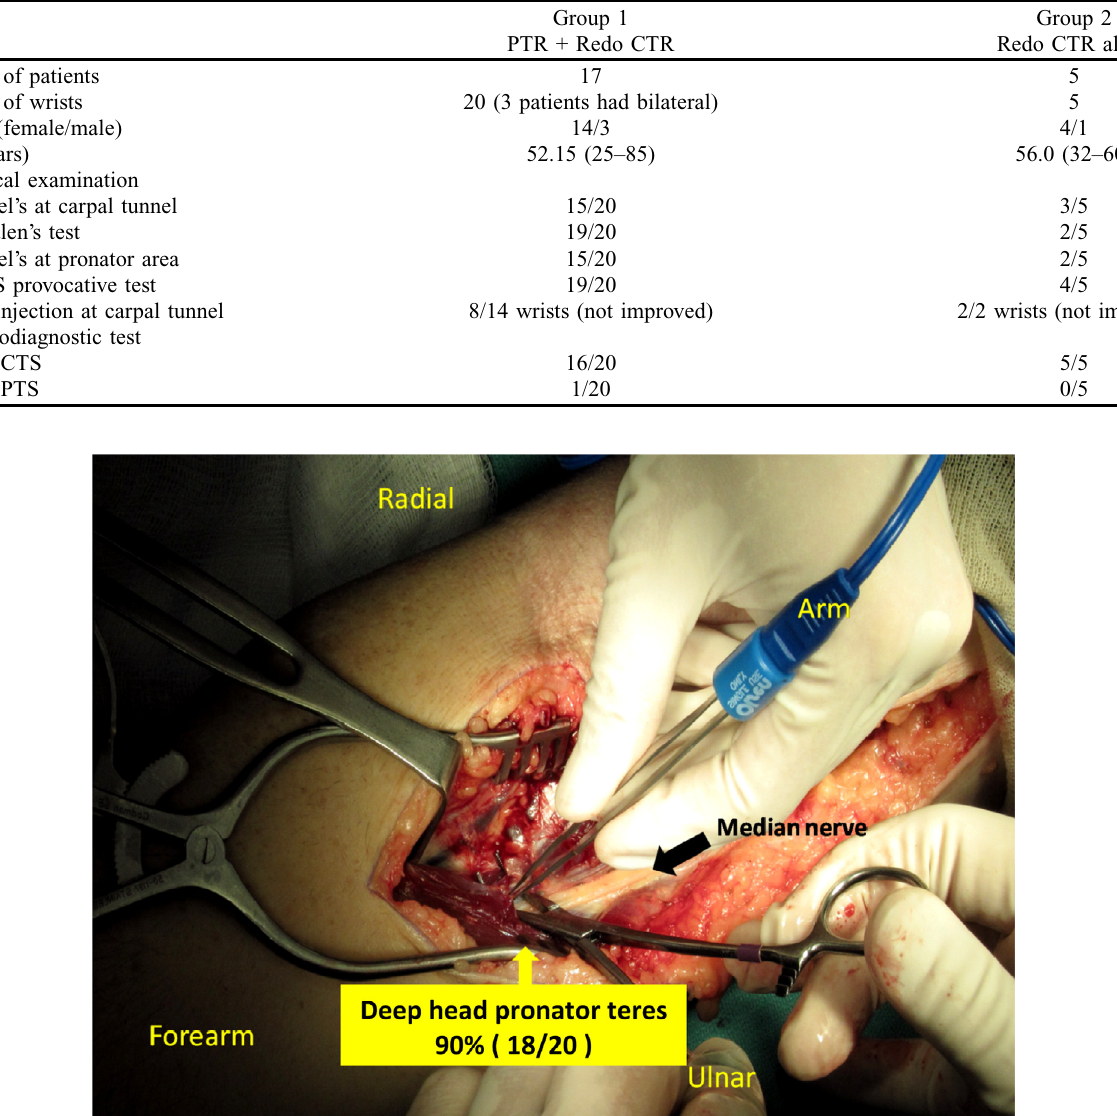
Figure 3. The most common pathologic finding in pronator